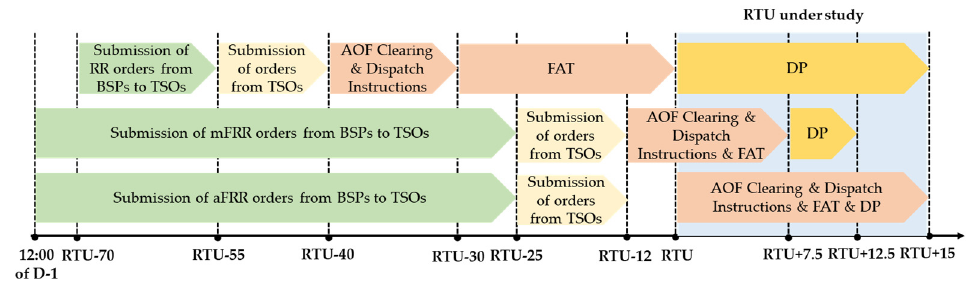
Figure 2. Illustration of the sequence of the balancing processes and the respective timings.